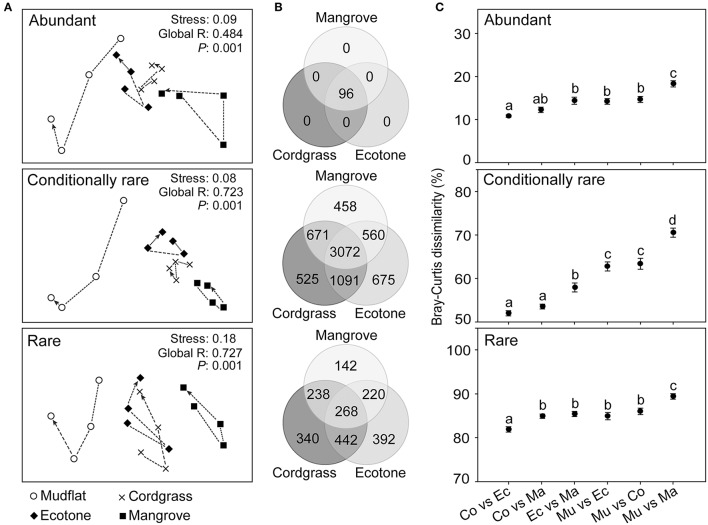
Comparison of beta-diversity of the soil bacterial communities among different types of vegetation zones. (A) Non-metric multidimensional scaling (NMDS) ordination of soil bacterial communities based on the Bray-Curtis dissimilarity. Points are connected by dash lines according to the progression of time (from spring to winter). (B) Venn diagram showing the number of OTUs (96 abundant OTUs, 7,052 conditionally rare OTUs, 2,042 rare OTUs) that are unique and shared between three different types of vegetation zones. (C) Pairwise Bray-Curtis dissimilarity of bacterial communities among different vegetation types. Mu, mudflat; Co, cordgrass; Ec, ecotone; Ma, mangrove. Significant differences (P < 0.05) between vegetation types are indicated by different letters of the alphabet. Statistical analysis is Student's t-test with Bonferroni correction (n = 16). Data are means ± standard error (error bars).